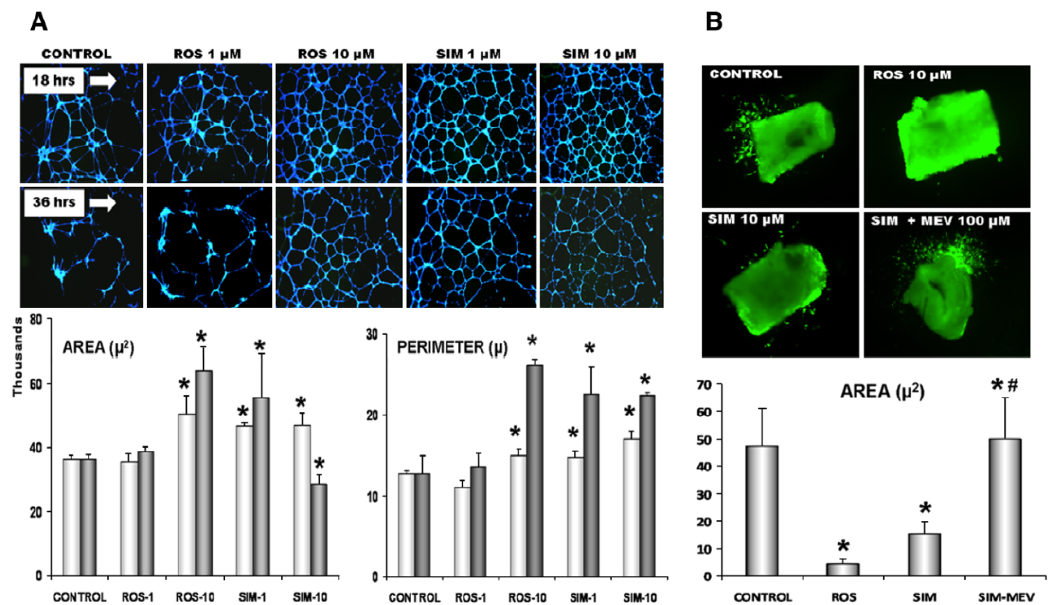
Figure 2. Induction of angiogenesis and vasculogenesis by statins. ( A ) Matrigel angiogenesis assay. HUVECs were exposed to rosuvastatin (Ros) and simvastatin (SIM) at 1 and 10 µ M for 18 (upper panel of images) and 36 h (lower panel). Representative images show cells loaded with calcein for fluorescent analysis: Gr * p < 0.05 vs. untreated control. ( B ) Representative images showing the effects of ROS pretreatment with 100 µ M L-mevalonate on simvastatin-treated rings; the graph displays simvastatin-treated aortic rings. Data is shown as means ± SE, based on 3–4 independent experiments. Reproduced with permission from